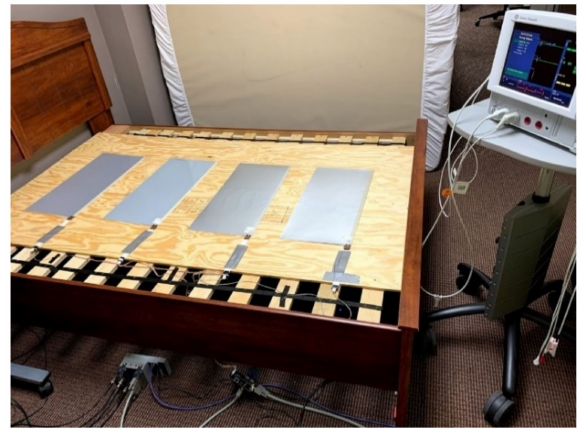
Figure 3. Image of the bed system from another angle, accompanied by the CardioCap 5 patient monitor. The analog conditioning and National Instruments data collection hardware can be seen under the